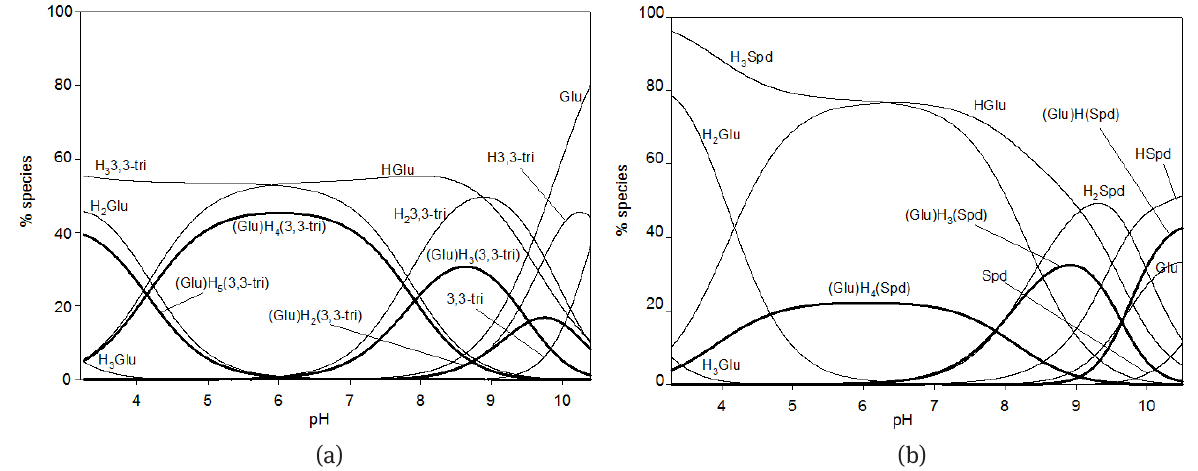
Figure 1: Distribution diagrams for the Glu/3,3- tri and Glu/Spd systems; percentage of the species refers to total Glu. (a) Glu/3,3- tri : C = 1.0 x 10 -2 M; C = 1 x 10 -2 M; (b) Glu/Spd: C Glu 3,3- tri